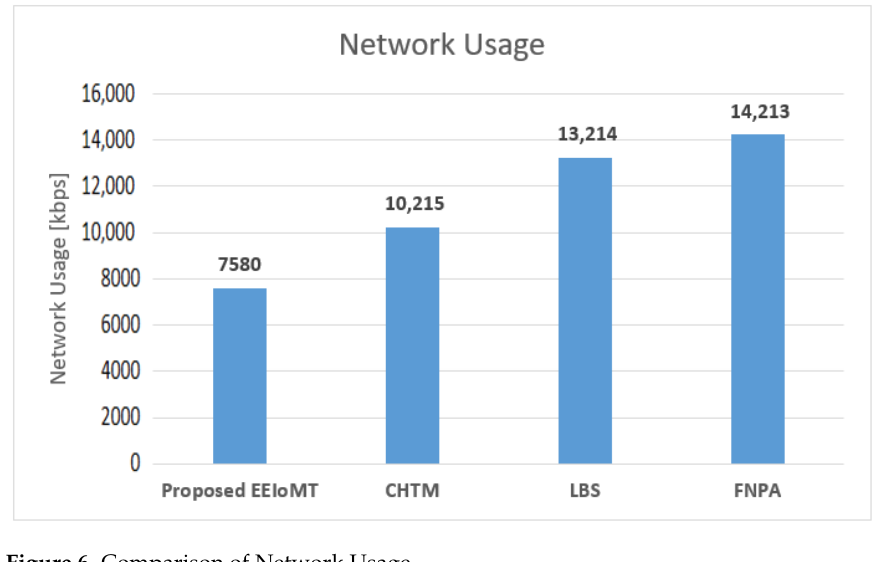
Figure 5. Comparison of Average Energy Consumption.